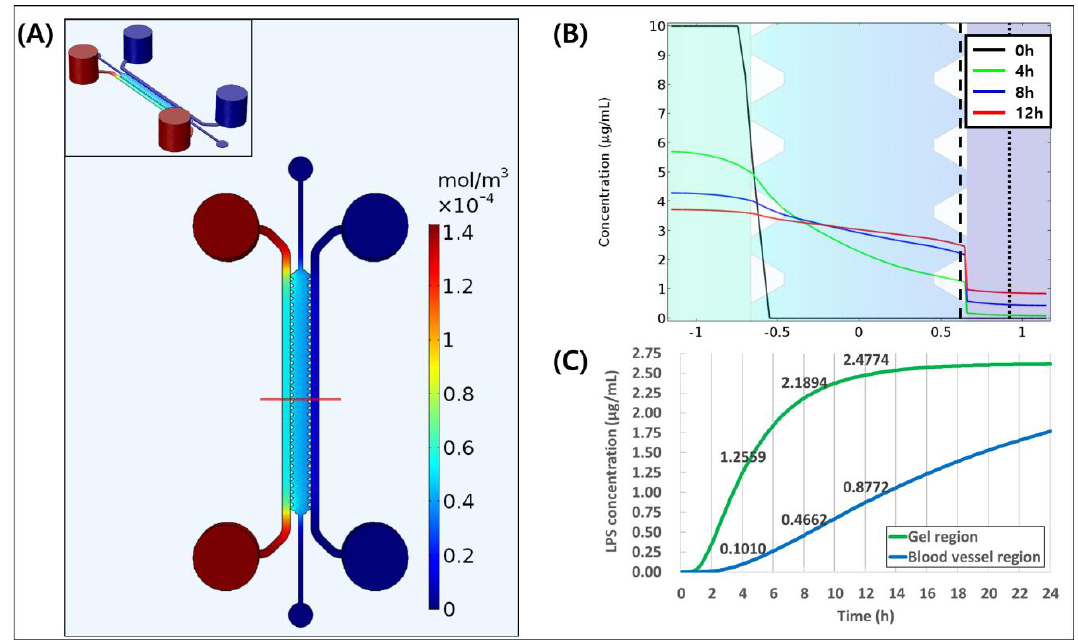
Figure 2. 3D simulation of LPS di ff usion in microfluidic chip. ( A ) The distribution of Lipopolysaccharide (LPS) concentration inside the channel at 12 h. ( B ) The graph of LPS distribution of red line of ( A ) at 0, 4, 8, and 12 h. ( C ) LPS concentration in gel region (dashed line in ( B )) and in the blood vessel region (dotted line in ( B )).